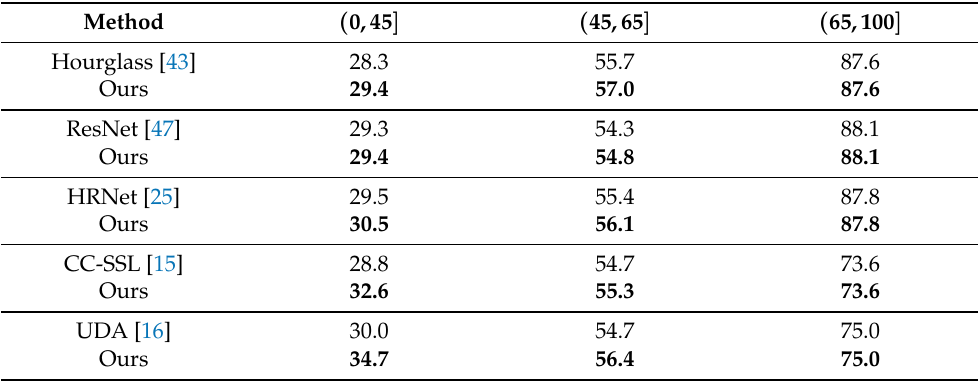
Table 3. PCK@0.05 accuracy on TD-Tiger (%). The best results are marked in bold.